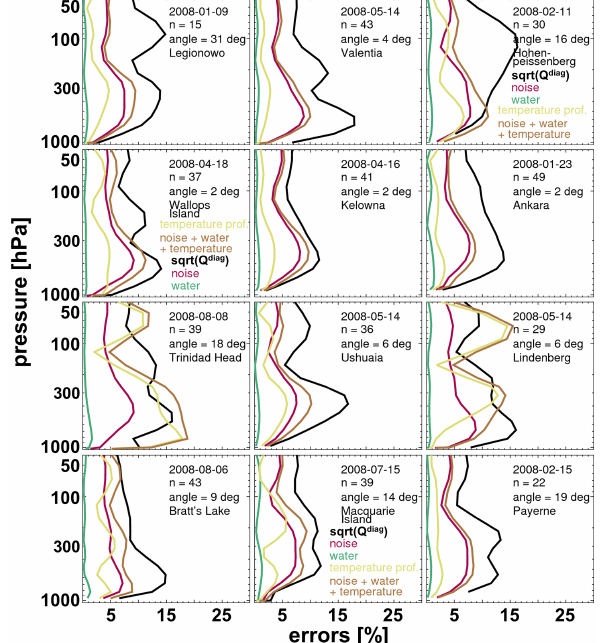
Figure 8. Theoretical random errors (brown lines) and empirical random errors (black lines) calculated from the square root of the diagonal of the error covariance matrix Q (see Sect. 6.4) for selected